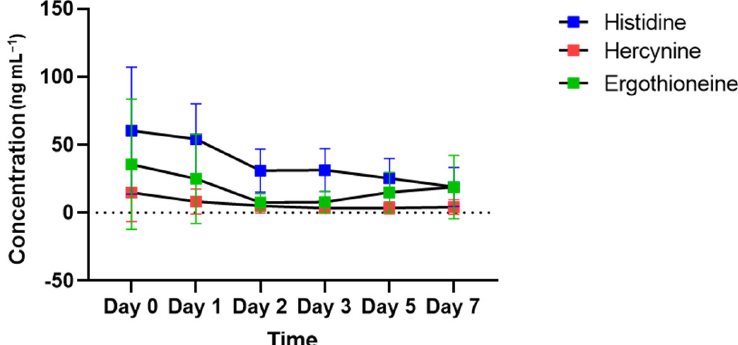
Figure 4. Time-dependent changes in the concentration of metabolites for the ergothioneine biosyn- thesis pathway in all subjects. Histidine (a precursor of ergothioneine) is indicated in blue, hercynine (produced from histidine) is indicated in red and ergothioneine (synthesized from hercynine) is indicated in green.